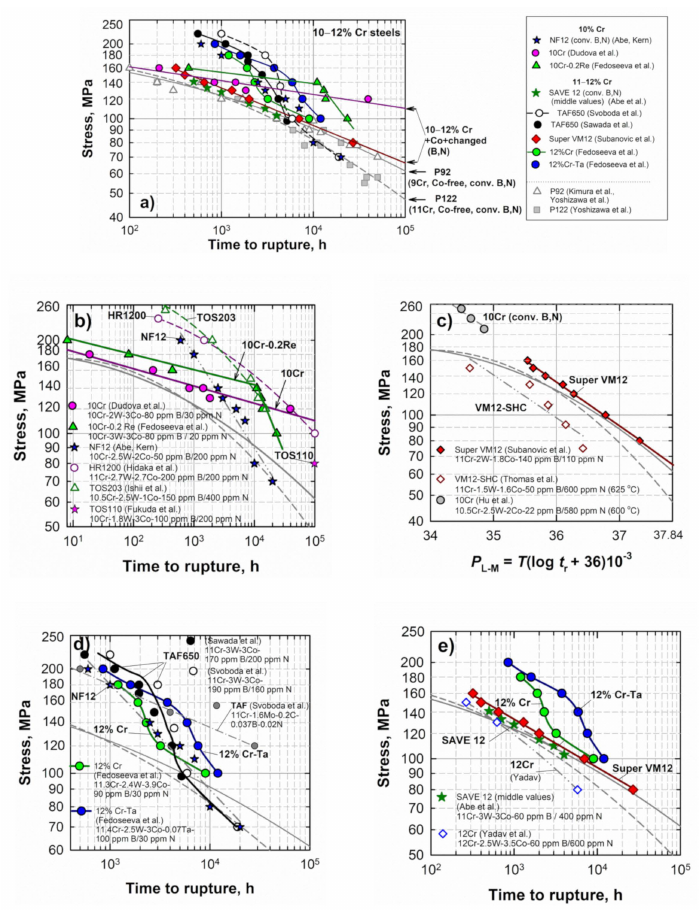
Figure 15. Time to rupture vs. stress curves of 10–12% Cr steels with increased B and decreased N contents in comparison with curves for 10–12% Cr steels with conventional B, N contents ( a , b , d , e ). Larson–Miller diagram ( c ). Experimental data from